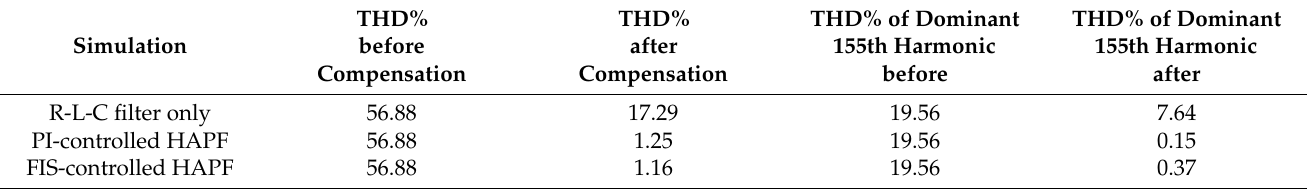
Table 4. Comparison of